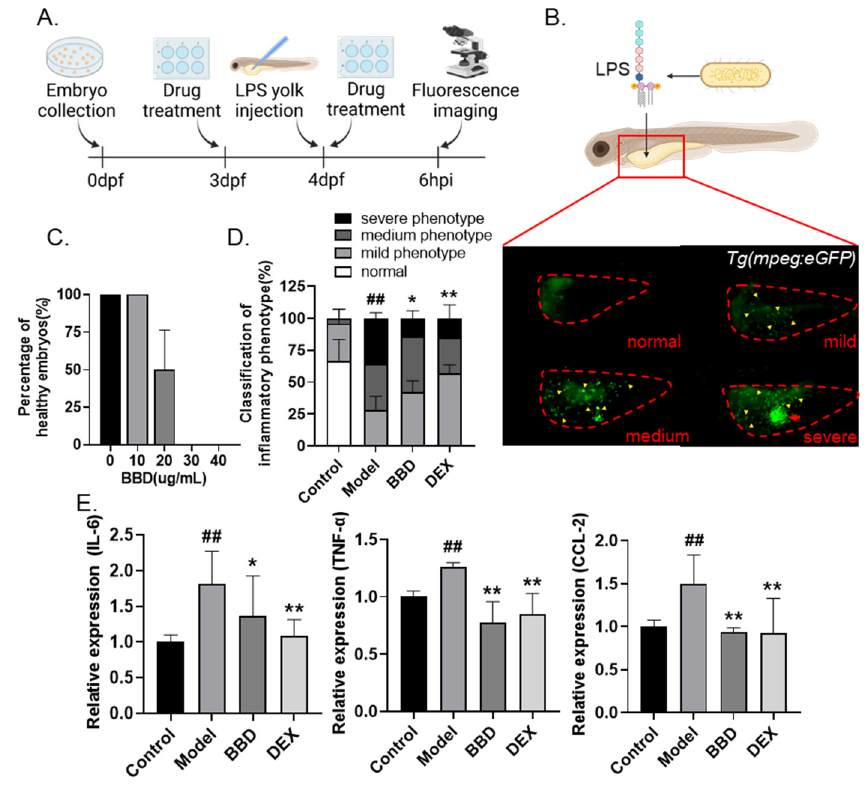
Figure 1. Anti-inflammatory effects of BBD on LPS-induced zebrafish inflammation model. ( A ) Flow chart of LPS-induced inflammation modeling. ( B ) Representative photos of zebrafish larvae of different degrees of inflammation. Embryos were classified as normal (no macrophage aggregation), mild ( ≤ 30 macrophages in yolk), medium (>30 macrophages but without an aggregation cluster), or severe (>30 macrophages and with an aggregation cluster). The red dotted line indicates zebrafish yolks, the yellow arrows indicate macrophages, and the red arrow indicates the aggregation cluster. ( C ) Toxicity of BBD treatment (n = 10). Larvae with cardiac edema, or body distortion, are defined as unhealthy. ( D ) The classification of inflammatory phenotypes in zebrafish embryos of different groups (n > 10). Control: PBS injection; model: LPS injection; DEX was used as positive control. The combined percentage of the medium and severe phenotypes was statistically analyzed among different groups. ( E ) The mRNA levels of IL-6, TNF- α , and CCL-2 in zebrafish embryos of different groups (n > 10). All the data are presented as the mean ± SEM of three independent experiments. # Compared with the control group; * compared with the model group; *, p < 0.05, ## or **, p < 0.01.